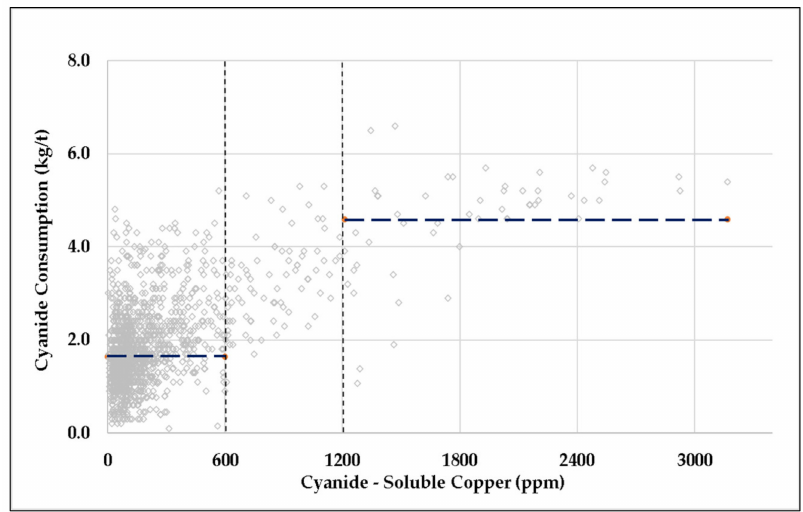
Figure 1. Summative data from Minera Florida from June 2020 to February 2021 regarding the pro- cessing of ores from the Alhu é district, demonstrating that spikes in cyanide consumption (expressed in kg of cyanide per tonne of feed) are associated with higher quantities of cyanide-soluble copper, carried by the feed. “Cyanide-soluble copper” includes copper from chalcocite/digenite, covellite, and bornite, but not chalcopyrite and